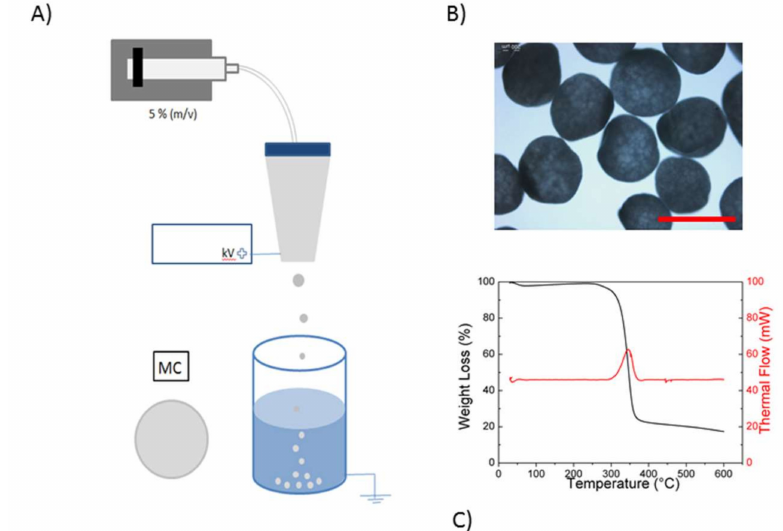
Figure 1. Ketoprofen lysinate (KL)-loaded mono-composition (MC) micro-vectors. ( A ) Scheme of capsule preparation; ( B ) qualitative evaluation of capsule morphology via optical microscopy (scale bar 500 µ m); ( C ) thermal analyses: weight loss (in black) and thermal flow (in red) with respect to the temperature, measured by TGA and DSC